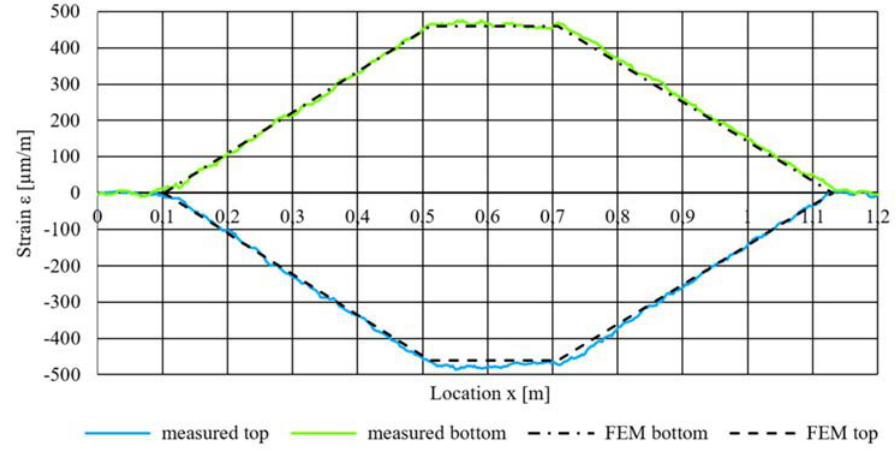
Fig. 5 Comparison of the strain gradient between four-point bending test and numerical calculation (FEM) for a load of 685 N and a resulting deformation of 10 mm in the middle of the field.